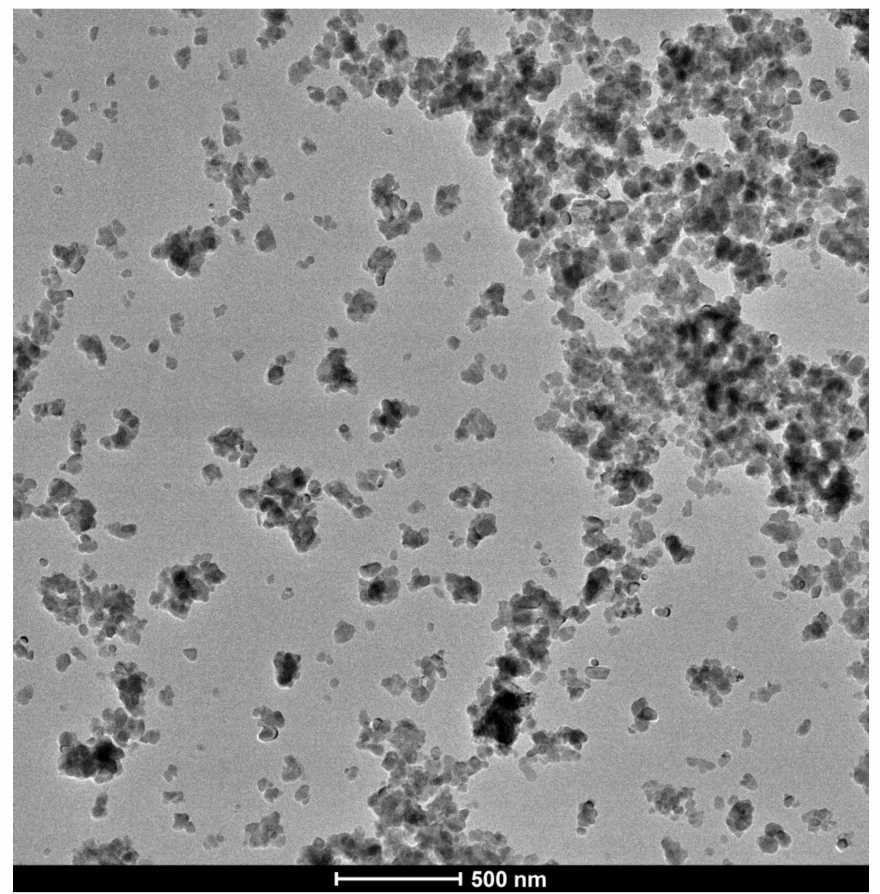
Figure 5. TEM image of the Pr0.5CFAP